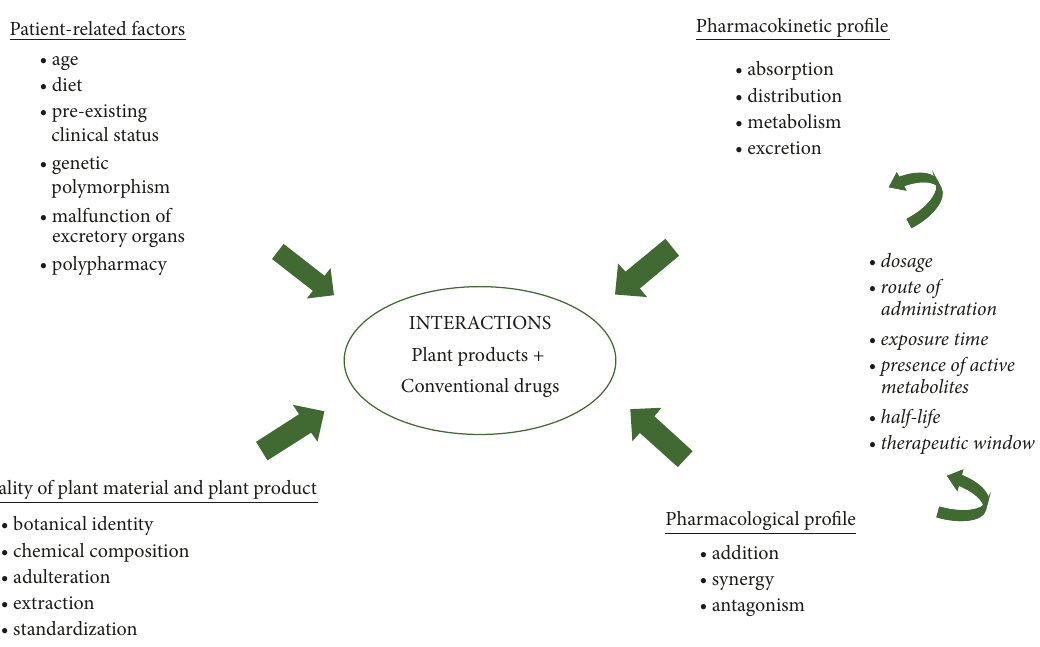
protein (MRPs) and breast cancer resistance protein (BCRP) and it affects the efflux of their substrates. SLC family,